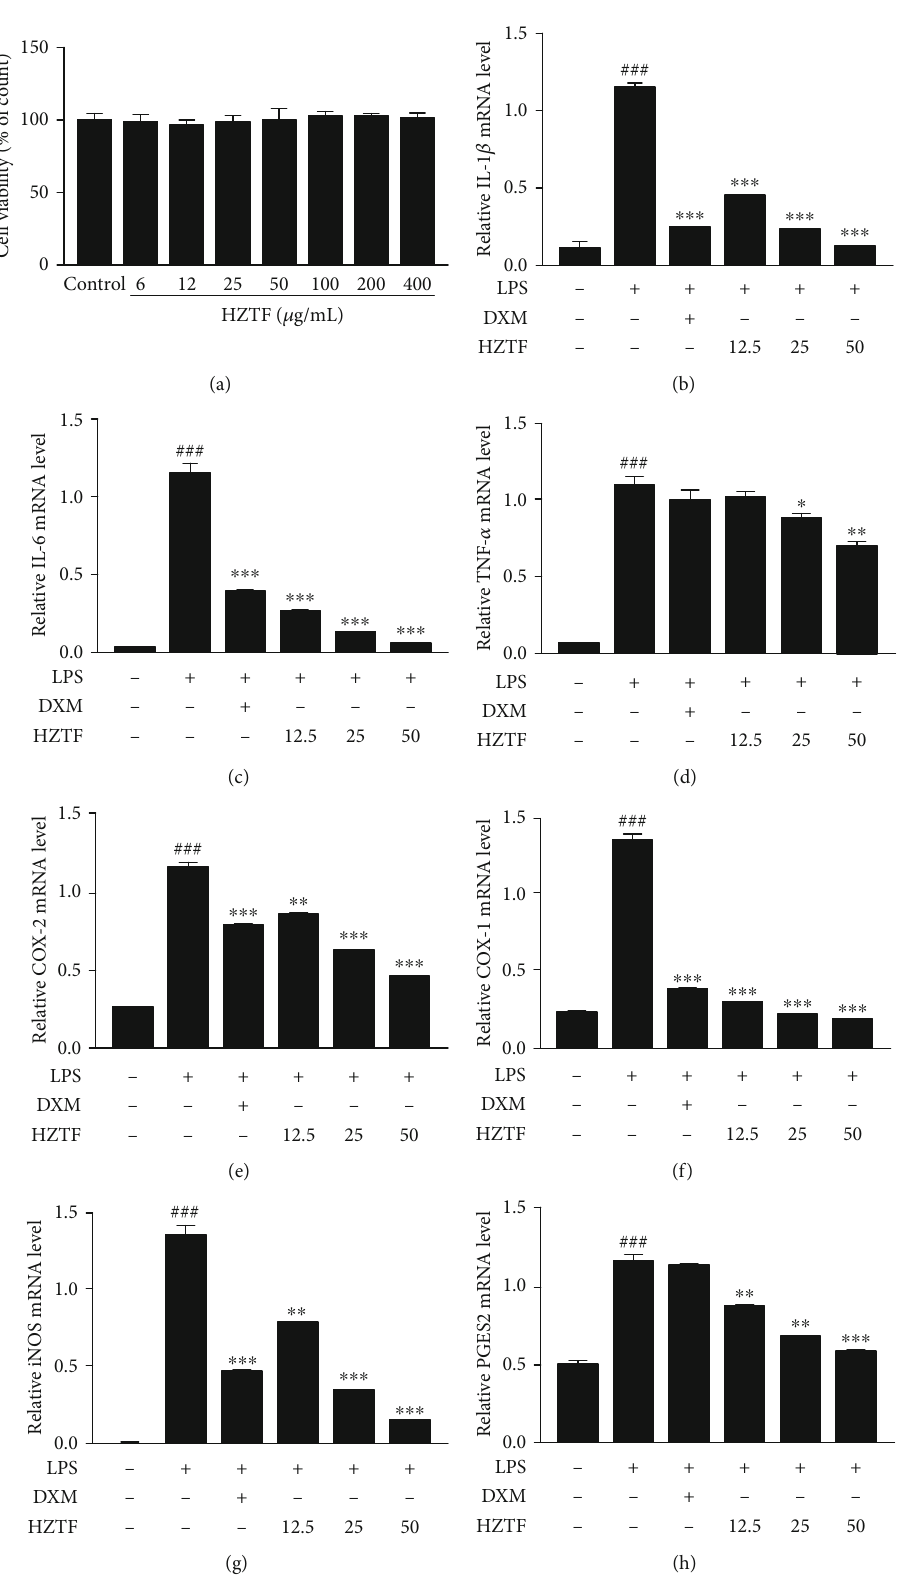
Figure 6: Anti-in fl ammatory e ff ect of HZTF in LPS-stimulated RAW264.7 macrophages. (a) Cell viability as determined by the MTT assay. The relative mRNA expression of (b) IL-1 β , (c) IL-6, (d) TNF- α , (e) COX-2, (f) COX-1, (g) iNOS, and (h) PGES2, following pretreated with di ff erent doses of HZTF for 2h and stimulated by LPS (100ng/mL) for 6h. Results were presented as means ± SD ( n = 3 ). ### P < 0 : 001 compared with the control group; ∗ P < 0 : 05 , ∗∗ P < 0 : 01 , and ∗∗∗ P < 0 : 001 versus the LPS